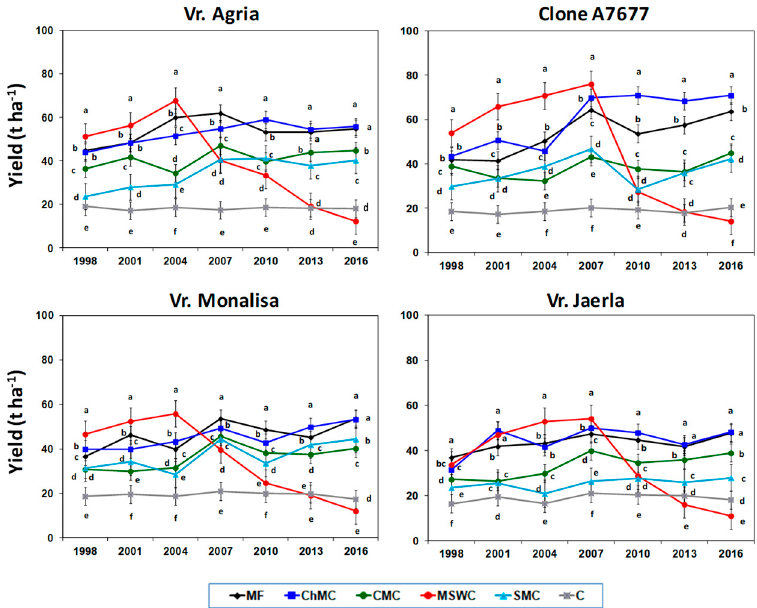
Figure 3. Evolution of the yield of potato tubers varieties Agria, Monalisa, Jaerla and clone A7677 (1998–2016) versus the application of compost from different organic amendments. The means with different lowercase letters within each season indicate significant differences between the treatments ( p < 0.001). Bars stands for standard deviations. MF: mineral fertilizer; ChMC: chicken manure compost; CMC: cow manure compost; MSWC: municipal solid waste compost; SMC: sheep manure compost; C: